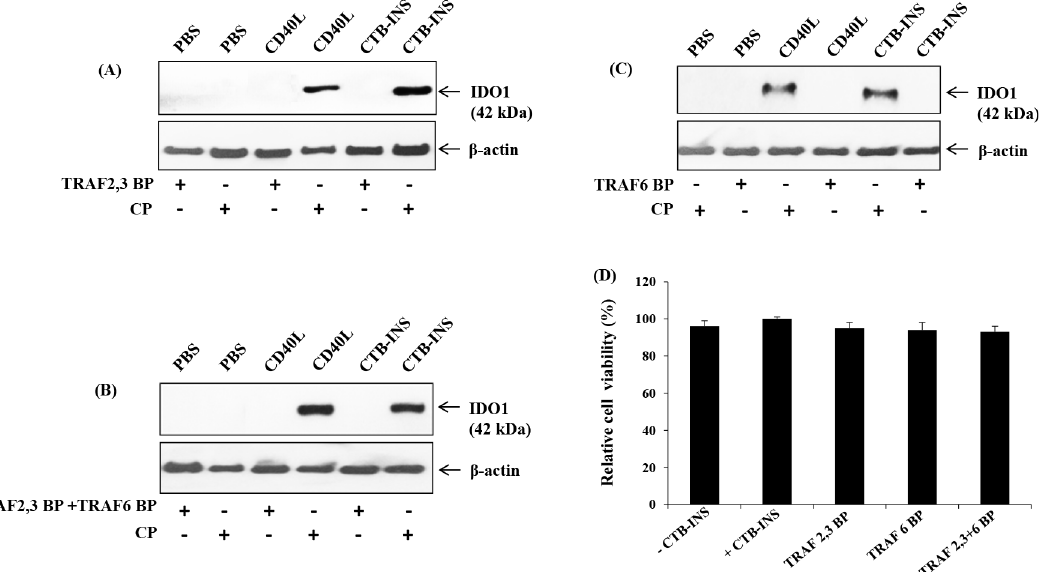
Fig 6. The TNFR-TRAF pathway is required for CTB-INS vaccine induction of IDO1 protein biosynthesis. In Panels (A,B,C) monocyte-derived DCs were inoculated with blocking peptides containing the amino acid sequence of TRAF2, 3 or TRAF6 binding sites of CD40 linked to the TAT 47 – 57 membrane transport peptide. After blocking peptide binding, the DCs were stimulated with 500ng/ml of CD40L (CD154), Immunex, Seattle, WA), LPS (1 μ g/ml) and CTB-INS (10 μ g/ml). Both CD40-TRAF2, 3 and CD40-TRAF6 blocking peptides impaired upregulation of IDO1 in response to CD154, LPS and CTB-INS. Each image is representative of two independent experiments. (D) Relative cell viability of cells treated with CTB-INS in combination with TRAF 6BP and TRAF 2, 3 BP.